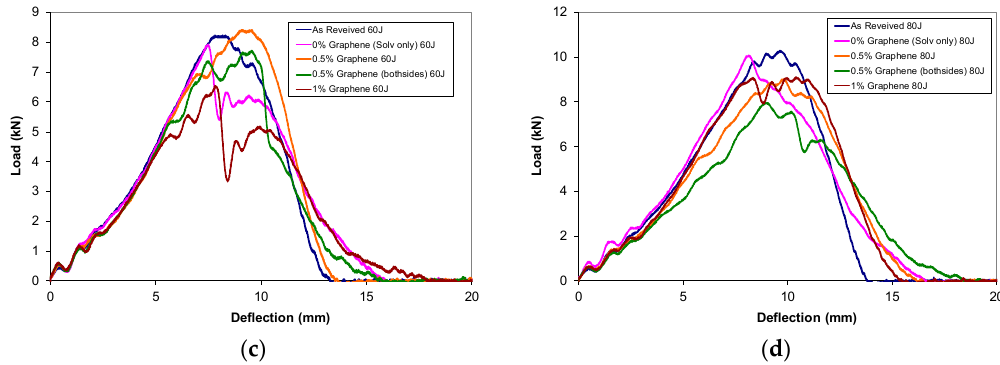
Figure 14. Load vs. deflection of glass fiber composites under impact ( a ) 20 J, ( b ) 40 J, ( c ) 60 J, and ( d ) 80 J.